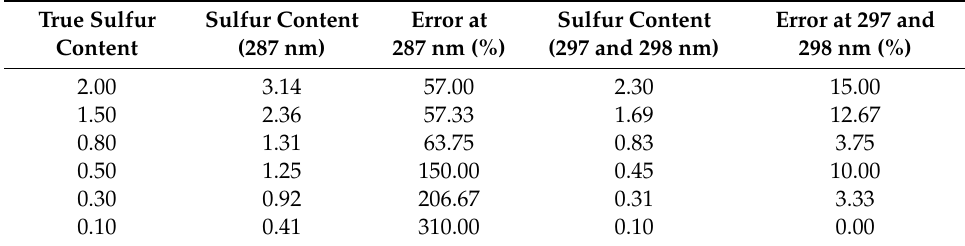
Table 3. Comparison between the average predicted and true sulfur